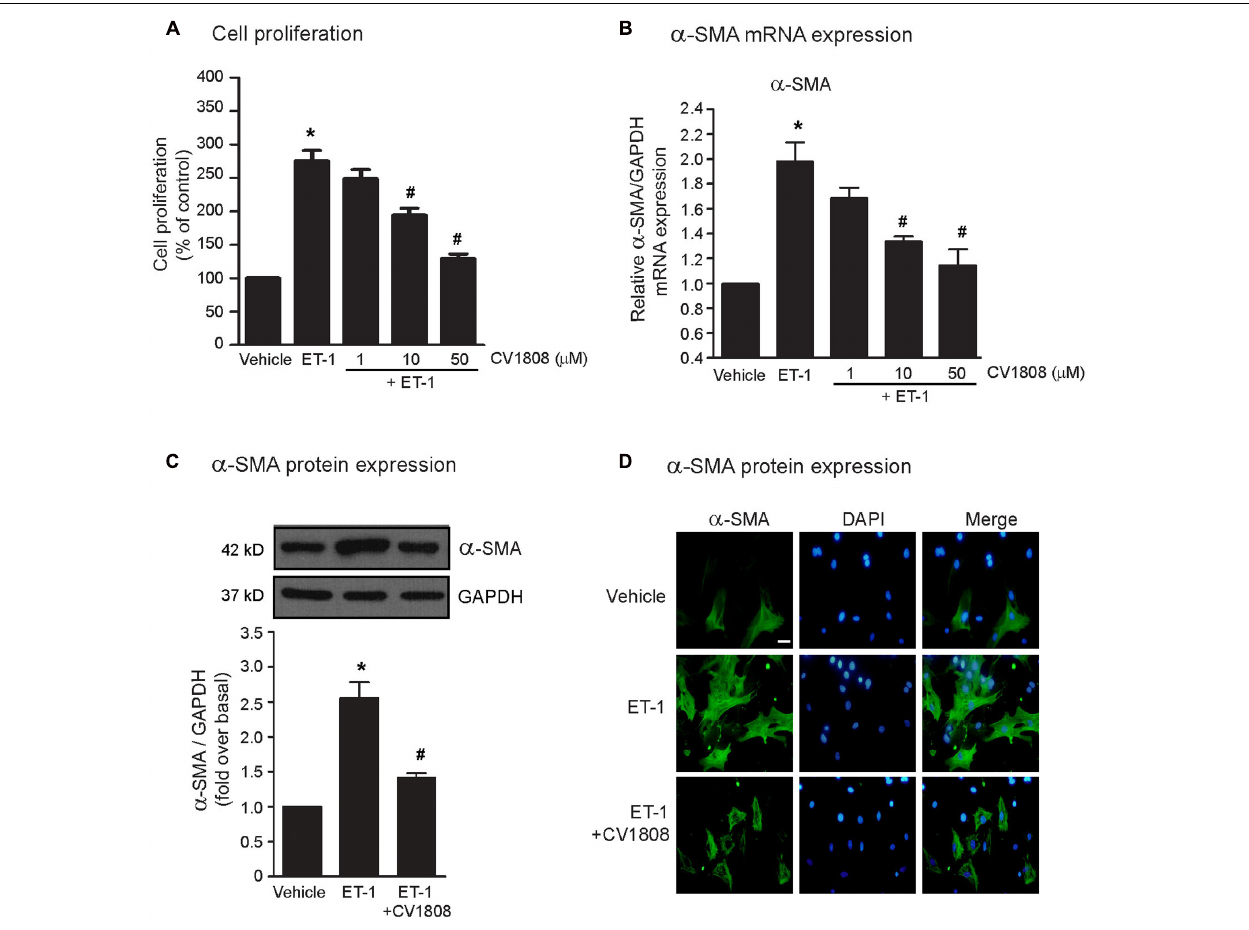
FIGURE 1 | Effects of CV1808 on ET-1-induced cell proliferation and α -SMA synthesis in cardiac fibroblast. (A,B) Cardiac fibroblasts were pretreated with various concentrations of CV1808 for 1 h and then stimulated with 20 nM ET-1 for 24 h (A) or 12 h (B) at 37 ◦ C. (A) Cell proliferation was quantified by MTT assay. The data were expressed as the percentage relative to the non-treated group, and shown as mean ± SEM ( n = 4). (B) Relative α -SMA mRNA levels were quantified and shown as the mean ± SEM ( n = 4). ∗ P < 0.05 vs. control; # P < 0.05 vs. ET-1. (C,D) Cardiac fibroblasts were pretreated without or with 10 µ M CV1808 for 1 h and then stimulated with 20 nM ET-1 for 24 h at 37 ◦ C. (C) Relative α -SMA protein levels were quantified and shown as the mean ± SEM ( n = 4). ∗ P < 0.05 vs. vehicle; # P < 0.05 vs. ET-1. (D) Cells were incubated with anti- α -SMA antibody followed by goat anti-mouse antibody (Alexa Fluor 488). The α -SMA was visualized by fluorescent microscope. Cells were stained for α -SMA (green) and nuclear staining of nucleus with DAPI (blue). Bar, 10 µ